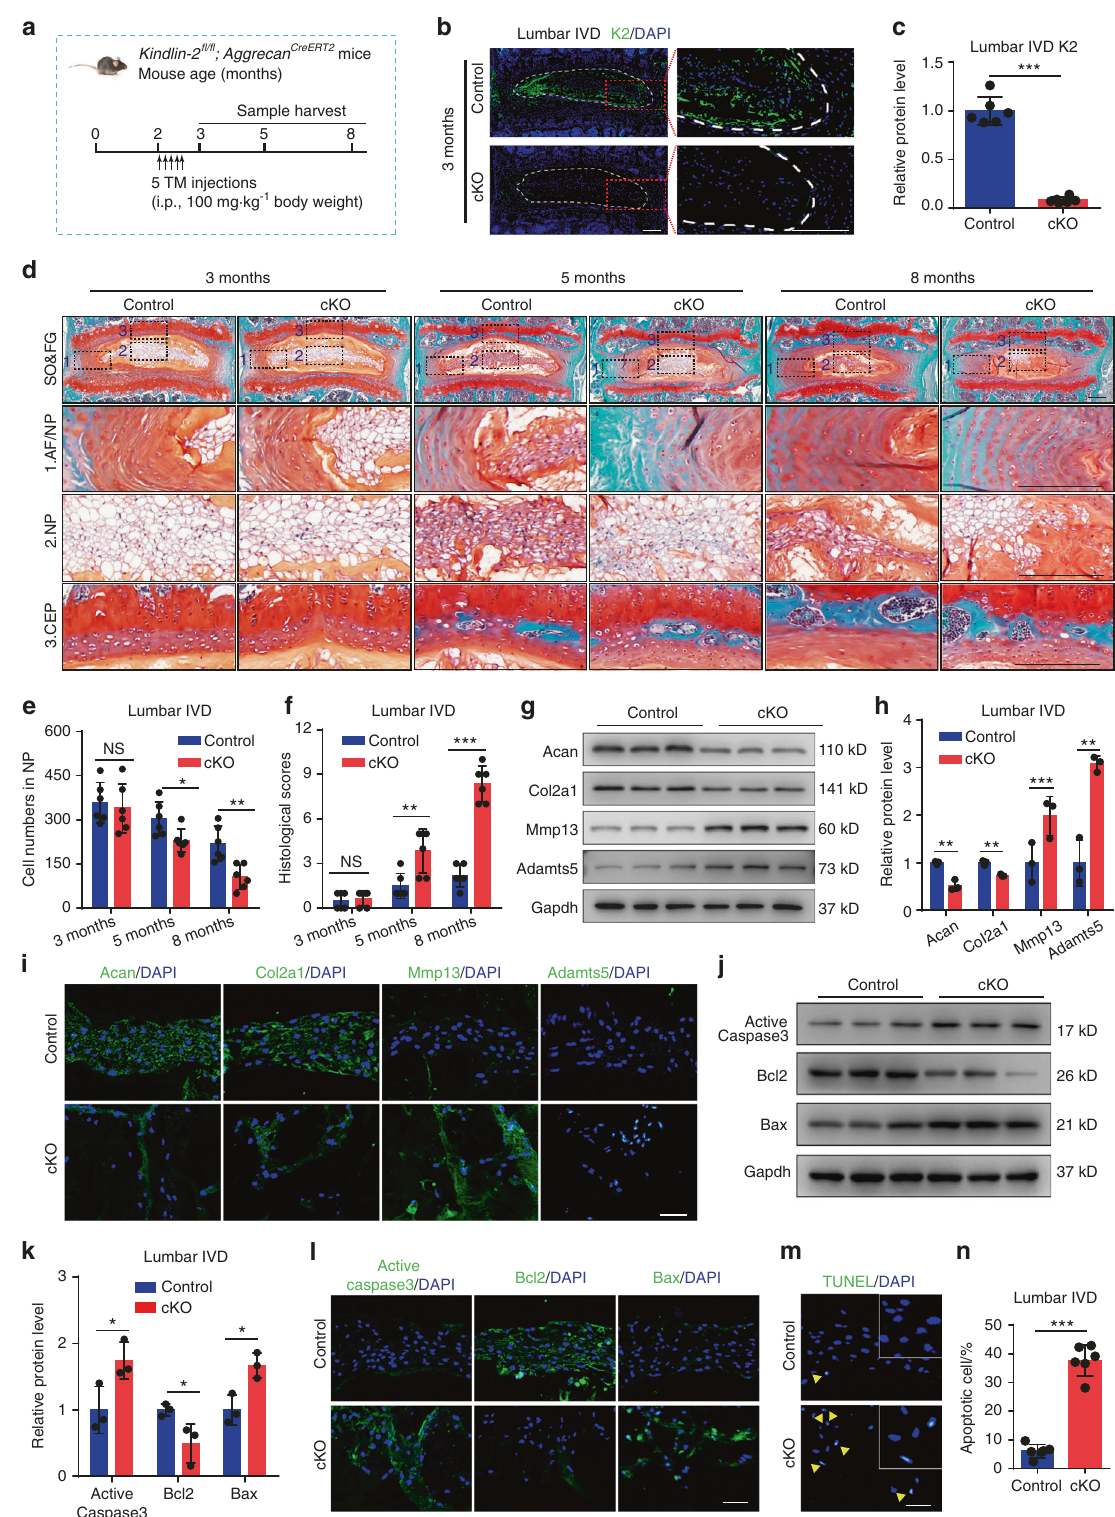
Fig. 2 Kindlin-2 deletion results in spontaneous and progressive IVDD in lumbar IVDs in mice. a A schematic illustration of the experimental design. b , c IF staining of K2 in lumbar IVDs in control and Kindlin-2 conditionally knockout (cKO) mice at 3 months of age. Scale bar, 200 μ m. n = 6. d , f SO&FG staining and histological scores of lumbar IVDs in control and cKO mice at 3, 5 and 8 months of age. Scale bar, 200 μ m. n = 6. e Cell numbers of NP in control and cKO mice at 3, 5, and 8 months of age. n = 6. g , h , j , k Western blotting analyses of Aggrecan (Acan), Collagen type II (Col2a1), a disintegrin and metalloproteinase with thrombospondin motif 5 (Adamts5) and matrix metalloproteinase 13 (Mmp13) as well as active Caspase3, Bcl2 and Bax in lumbar IVDs in control and cKO mice at 8 months of age. n = 3. i , l IF staining of Acan, Col2a1, Mmp13 and Adamts5 as well as active Caspase3, Bcl2, and Bax in NP tissues in lumbar IVDs of control and cKO mice at 8 months of age. Scale bar, 50 μ m. m , n TUNEL staining of NP tissues in lumbar IVDs of control and cKO mice at 8 months of age. Scale bar, 50 μ m. n = 6. NS, no statistical signi fi cance, * P <0.05, ** P < 0.01, *** P